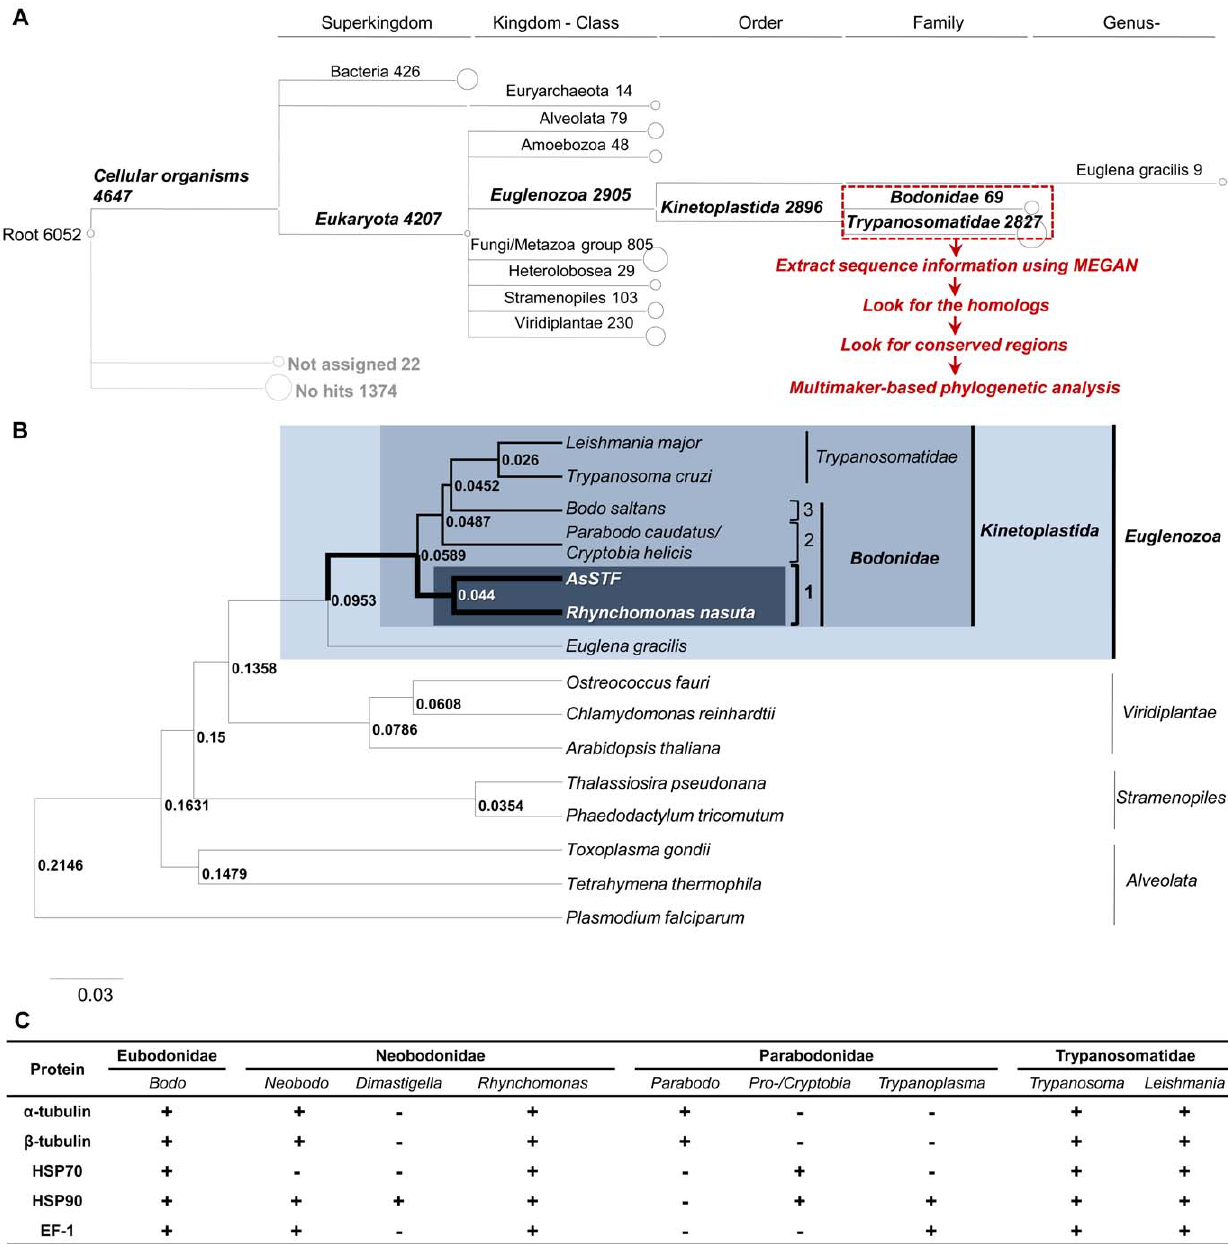
Figure 1. Multimarker-based phylogenetic analysis of the pathogenic flagellate. (A) A MEGAN tree, based on the output of BLASTX against the NCBI-nr database (E-value , 10 2 3 ), is shown. Transcripts lacking BLAST matches are assigned to the special node ‘‘no hits,’’ and those not assigned for reasons associated with the algorithm are denoted as ‘‘unassigned.’’ Bacteria are presented to the superkingdom level and Eukaryota are aligned at the kingdom to class level, except for Kinetoplastida, where the highest matching at the subclass level is shown. (B) Phylogenetic tree constructed upon a concatenation of three conserved proteins ( a -tubulin, heat shock protein 70 and heat shock protein 90) consisting of 1,184 amino acids using the BEAST software. Elongation factor-1 (EF-1) was excluded due to its partial nature. The distance scale is given under the tree. (C) List of putative proteins with regions conserved across species. The respective sequencing reads have been deposited in GenBank (Accession numbers JU062373 through JU062376). phosphate buffer (titrated to pH 3.5 and pH 5.5 by using NaOH proteolytic activity at pH 3.5, 5.5, and 7.4, respectively. Fibro- and HCl) using tangential flow filtration with Amicon Ultra YM- nectin (FN; Sigma-Aldrich) was used as a substrate, and 10 filter tubes (Millipore, Billerica, MA, USA) for concentration, fibronectinolytic activity was examined by 12.5% sodium dodecyl desalting, and buffer exchange. Thereafter, 500 m l of pathogens sulfate-polyacrylamide gel electrophoresis (SDS-PAGE). In brief, stored samples of filtered/sterilized seawater containing purified (approximately, 10 3 flagellates ml -1 ) were lysed with the same flagellates were thawed and transferred to PBS (pH 7.4) or 0.1 M volume of 1% Triton X-100, lightly fixed with 0.5% glutaralde-